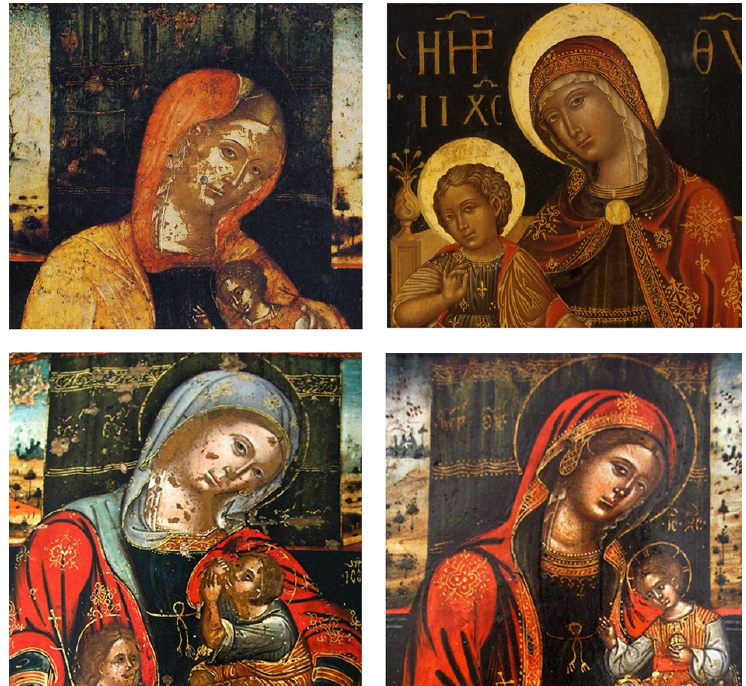
Figure 6. Angelos Bitzamanos. Madonna and Child (detail). Saint Petersburg, Hermitage Museum ( top left ) © Musei Vaticani. Reproduced with permission; Angelos Bitzamanos. The Scottivoli altarpiece (detail), 1508. Vatican City, Apostolic Palace ( top right ); Angelos Bitzamanos. Madonna and Child (detail). Split, Arheološki Muzej ( bottom left ); Angelos Bitzamanos. Madonna and Child (detail). Bari, Pinacoteca Provinciale ( bottom right ). Author’s photos; Figure created by author.